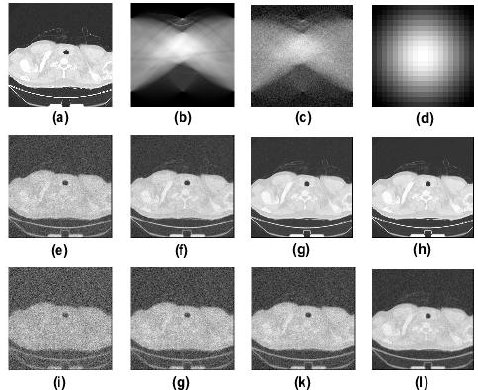
Figure 1. Experimental images and results of the first CT image. The 1st row shows the sharp CT image (left) and the CT noisy projection for 100% of measurements (middle) as well as the 20 × 20 point spread function; the 2nd row shows the blind restoration reconstruction results for 40%, 60%, 80% and 100% of measurements, respectively, from left to right (SNR = 40 dB); the 3rd row shows the blind restoration reconstruction results for 40%, 60%, 80% and 100% of measurements, respectively, from left to right (SNR = 20 dB). ( a ) the sharp CT image; ( b ) the measured noisy projection (SNR = 40 dB); ( c ) the measured noisy projection (SNR = 20 dB); ( d ) the point spread function; ( e ) the reconstruction result (SNR = 40 dB, Sampling ratio = 40%); ( e ) the reconstruction result (SNR = 40 dB, Sampling ratio = 60%); ( f ) the reconstruction result (SNR = 40 dB, Sampling ratio = 80%); ( g ) the reconstruction result (SNR = 40 dB, Sampling ratio = 100%); ( h ) the reconstruction result (SNR = 20 dB, Sampling ratio = 40%); ( i ) the reconstruction result (SNR = 20dB, Sampling ratio = 60%); ( j ) the reconstruction result (SNR = 20 dB, Sampling ratio = 80%); ( k ) the reconstruction result (SNR = 40 dB, Sampling ratio = 40%); ( l ) the reconstruction result (SNR = 20 dB, Sampling ratio = 100%).